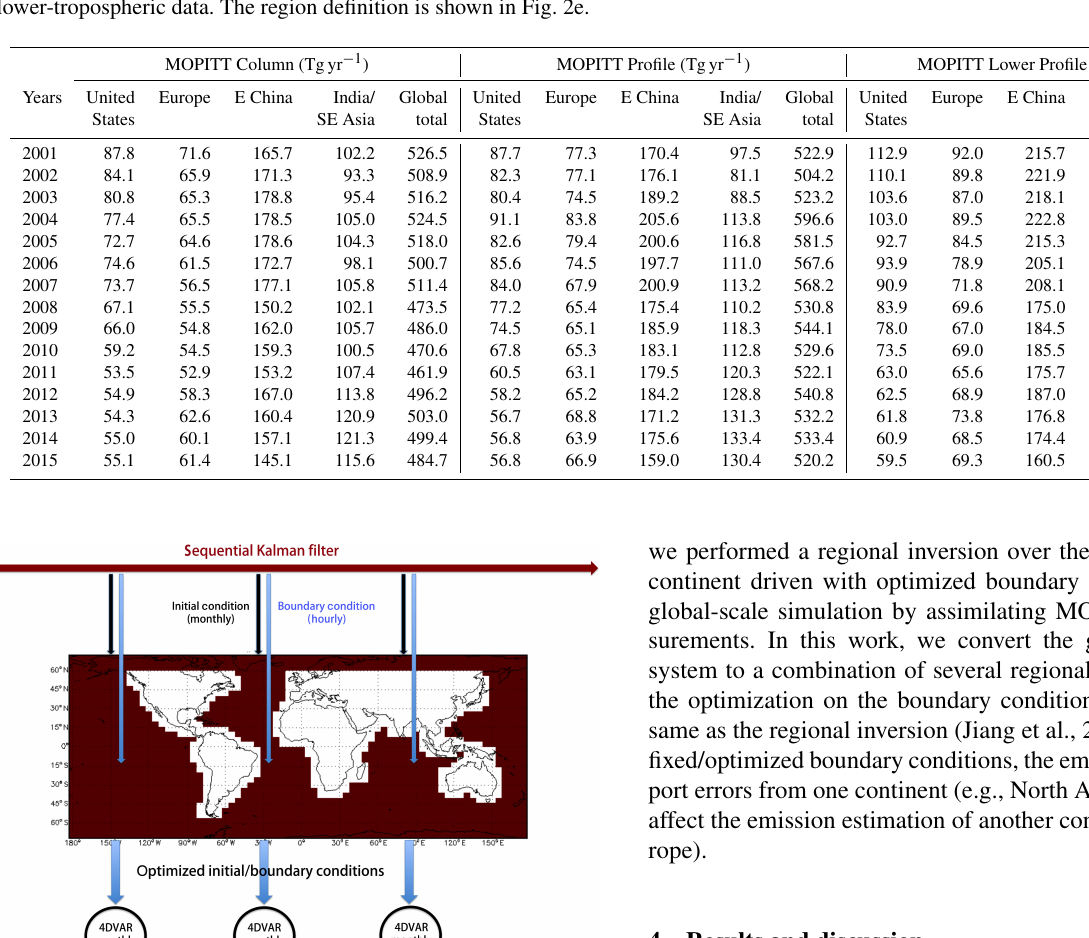
Table 1. Annual total anthropogenic CO emission in different regions, from 2001 to 2015, constrained with MOPITT column, profile and lower-tropospheric data. The region definition is shown in Fig. 2e.